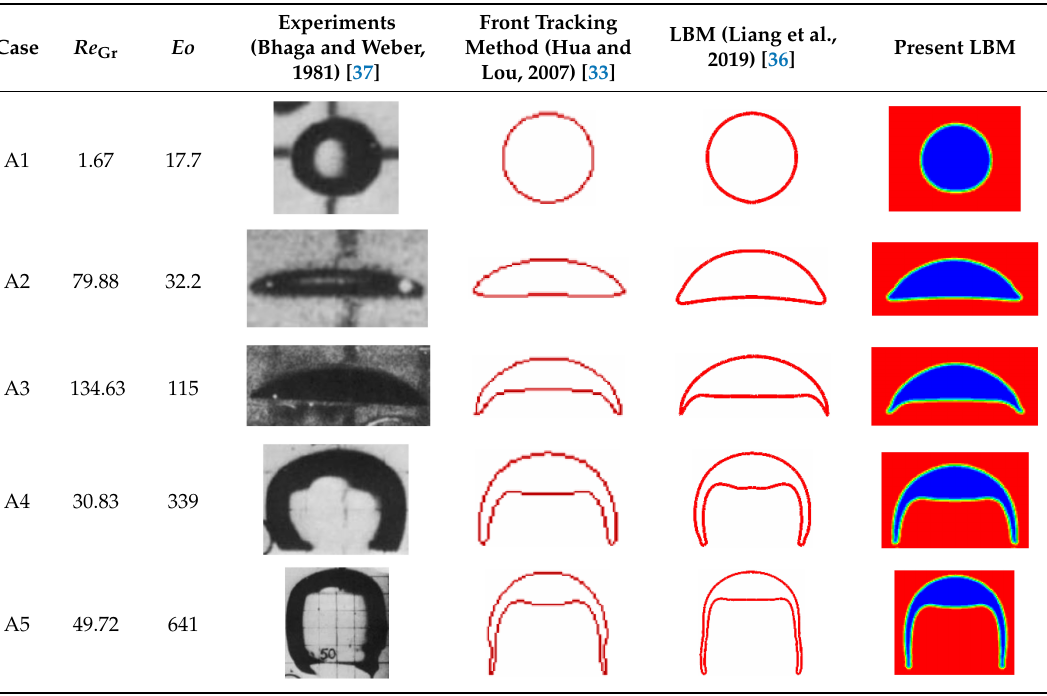
Table 1. Comparison of terminal bubble shapes observed in experiments and predicted by front tracking method, previous and present